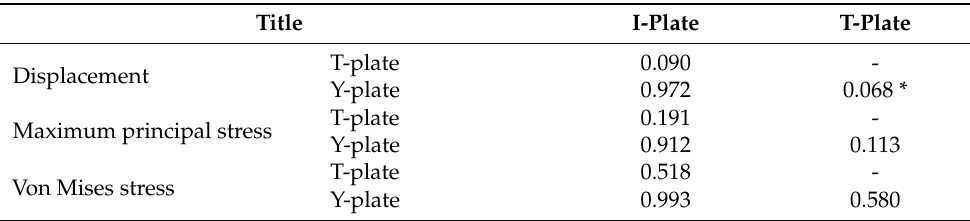
Table 5. Tukey’s multiple comparisons